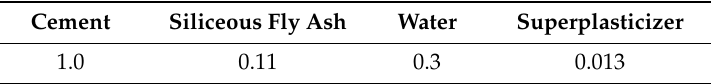
Table 5. Mass mixture proportions for the matrix of